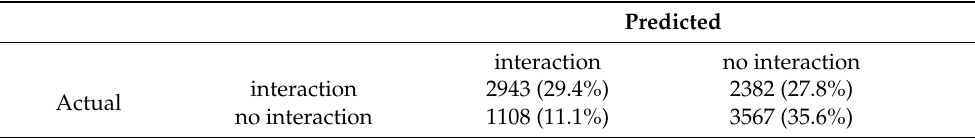
Table A9. Exemplary confusion matrix for interaction prediction with our model the ternary com- plex 6HR2 (one of the worst scoring complexes with an AUROC of 0.69, see Table A7). Details as in Table